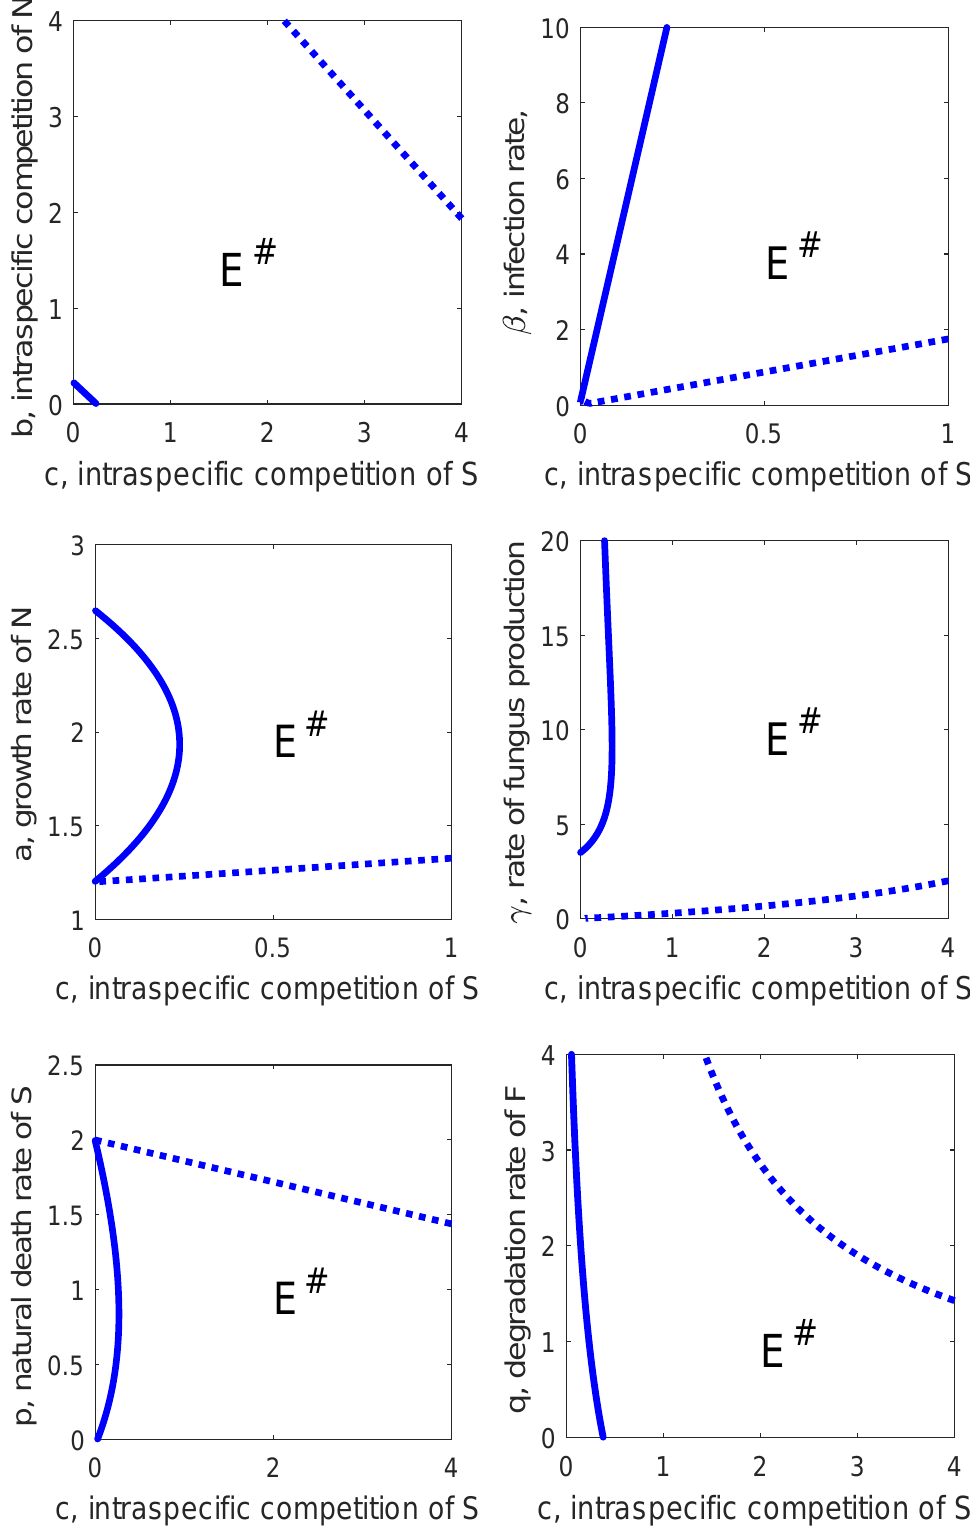
Fig. 7 Two parameter bifurcation analysis of the system (1) of the remaining six parameters as function of the bifurcation parameter c . Respectively, top to bottom and left to right, the former are b , β , s , γ , p , and q . The continuous blue line is the Hopf bifurcation curve. The dashed blue line represents the transcritical bifurcation from the coexistence equilibrium to disease-free steady